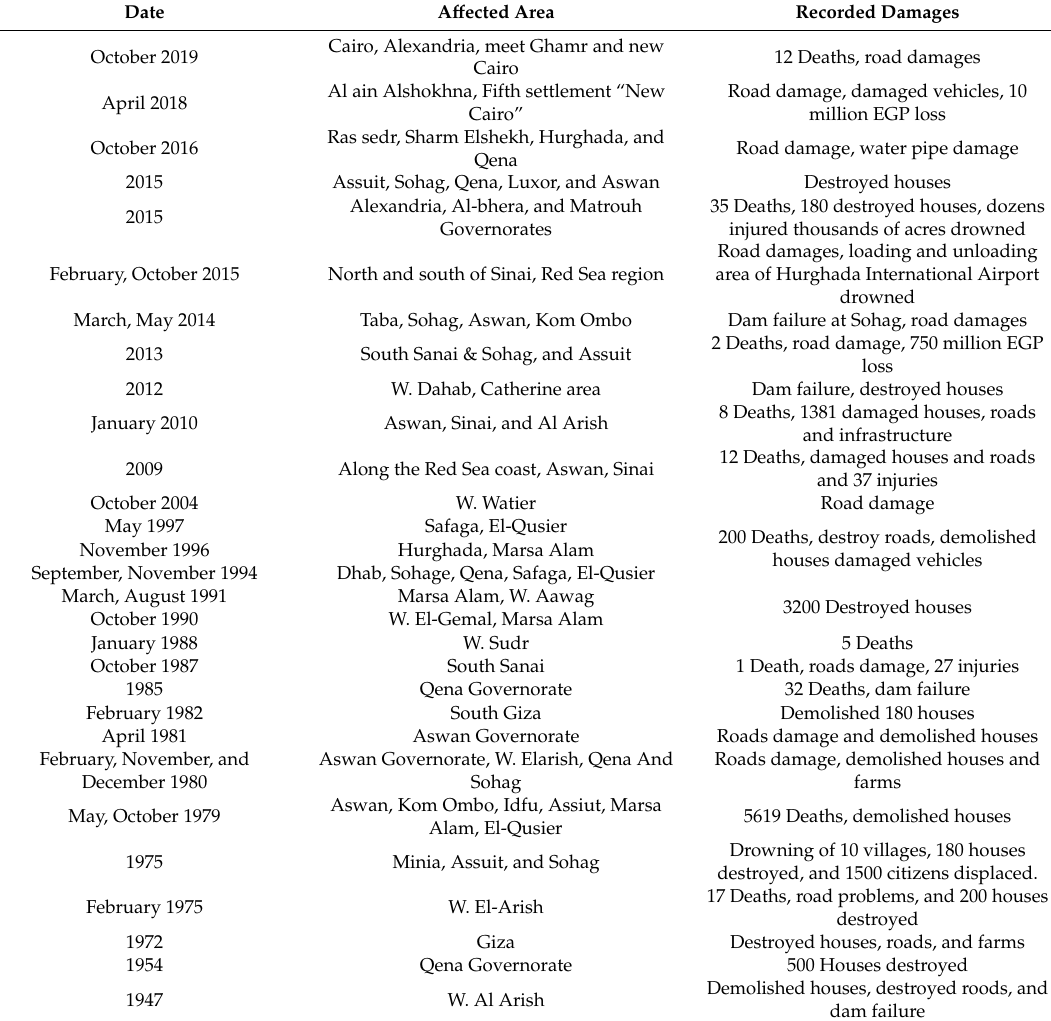
Table A1. The historical records of the hazardous flash floods that hit Egypt